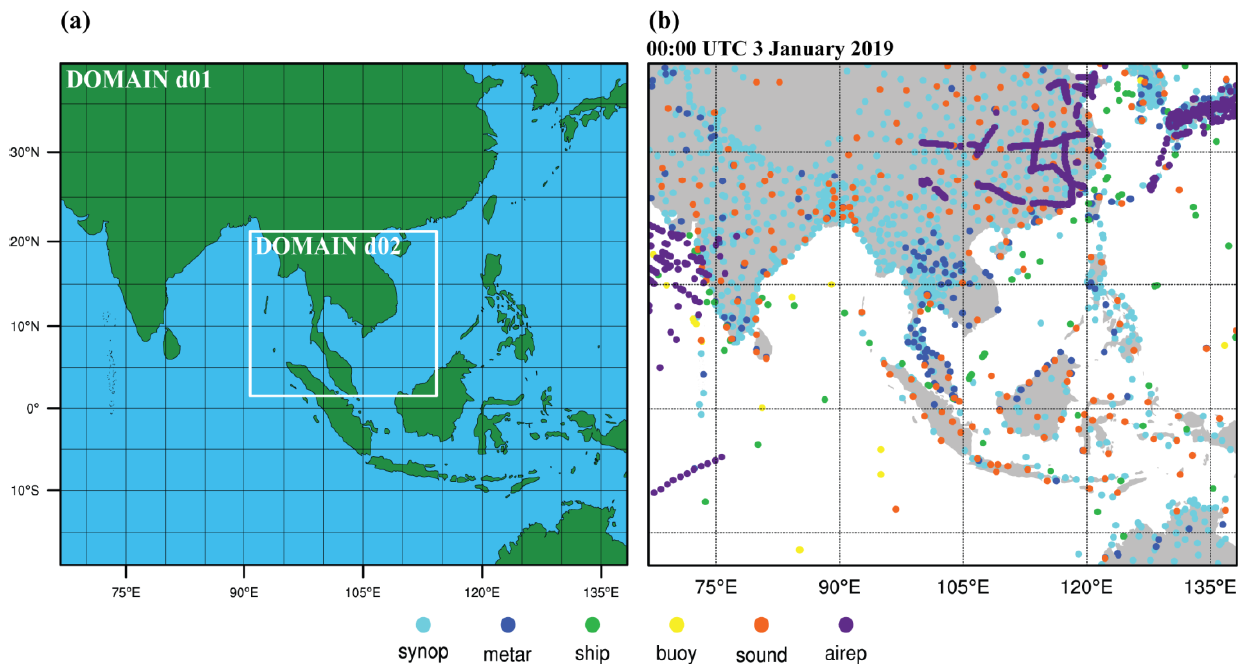
Figure 3. ( a ) Experimental domain for two nested domains used in WRF model simulations. Spatial resolutions are 12 and 4 km for domains 01 and 02, respectively. ( b ) Example of the locations and the distribution of conventional observations used valid at 00:00 UTC 3 January 2019.